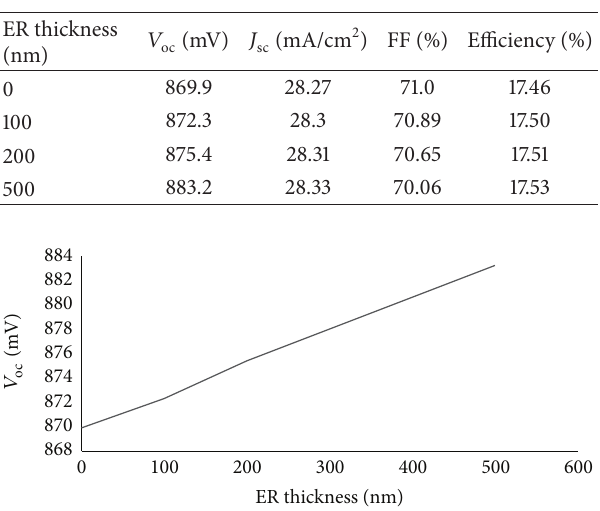
Table 3: Electron reflector layer thickness and cell performance. A barrier height of 0.3 eV and a doping of 7 × 10 16 cm −3 are assumed.